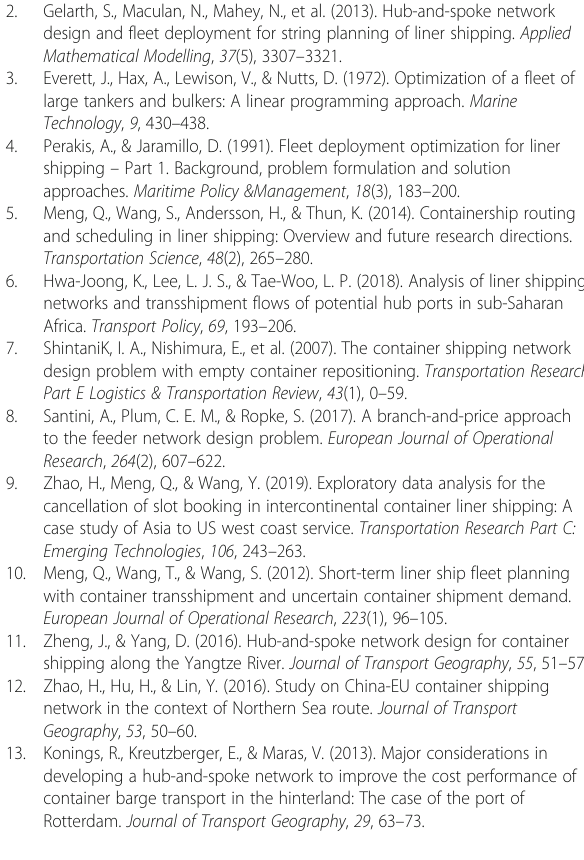
Table 16 Final Grey Correlation and the Evaluation